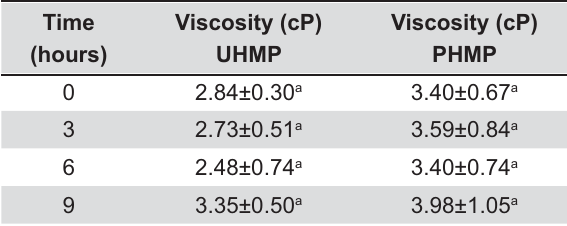
Table 1- Effect of time on the viscosity of untreated human milk and pasteurized milk maintained at a temperature